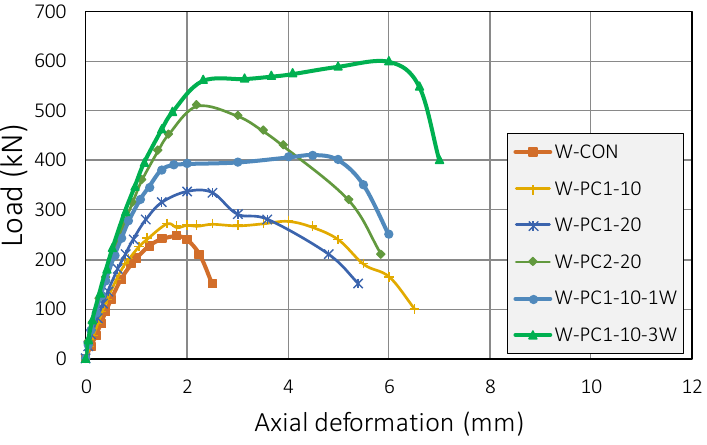
Figure 16. Experimental responses of all CCIHBM walls.